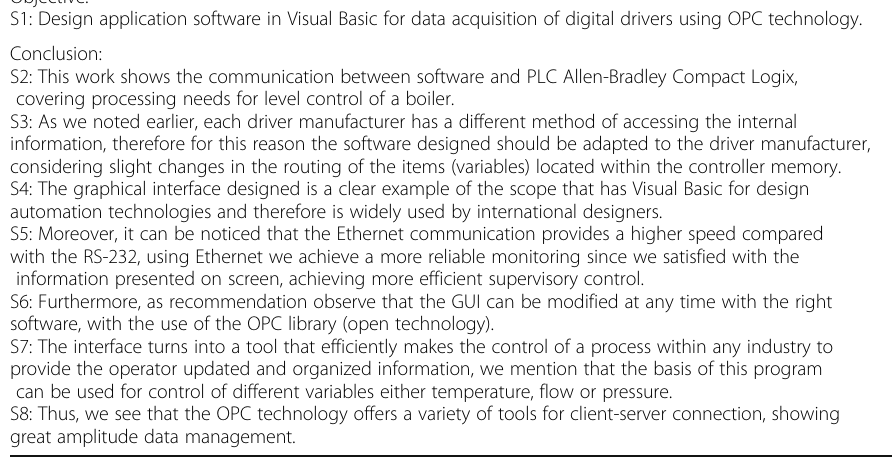
Table 2 Undergraduate objective-conclusion pair example